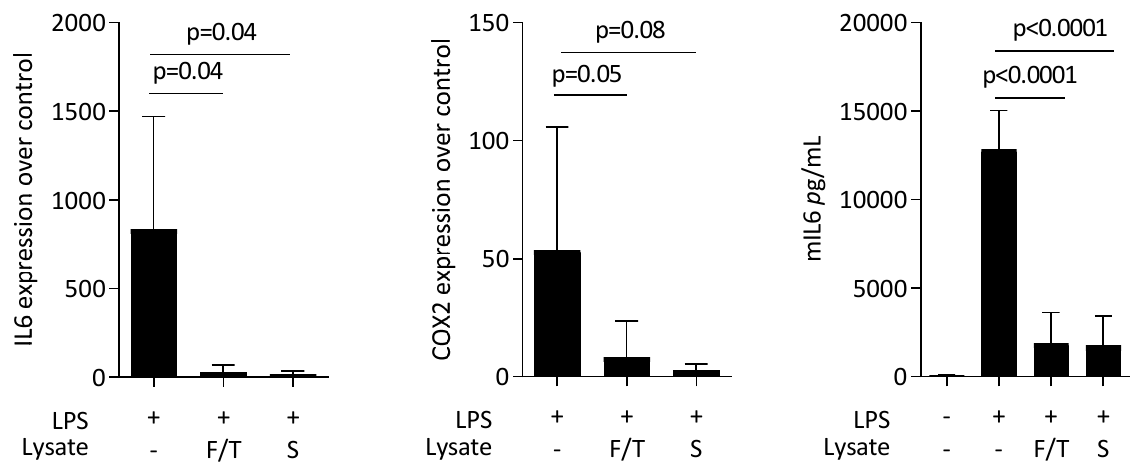
Figure 3. ST2 lysates reduce LPS-induced M1 polarization in primary macrophages. Primary bone- marrow-derived macrophages were exposed to ST2 lysates prepared by freeze/thawing (F/T) and sonication (S) with LPS. Data show the x-fold changes of IL6 and COX2 gene expression as well as the release of IL6 protein into the supernatant. The expression changes were normalized to an unstimulated control. The bars represent the mean and standard deviation of five independent experiments. Statistical analyses were based on RM one-way ANOVA.